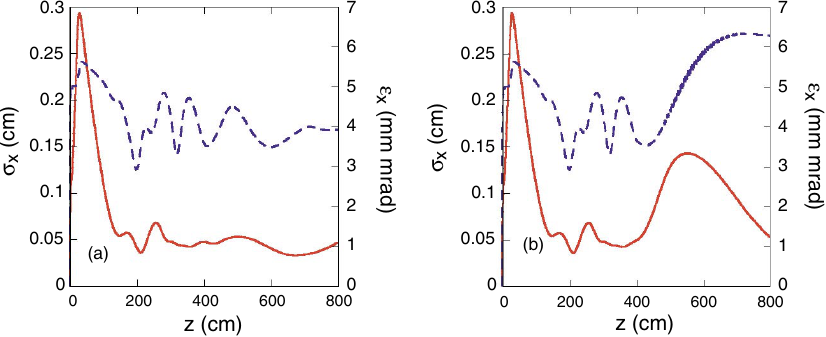
FIG. 22. (Color) PARMELA simulation of the rms spot size (solid line) and normalized emittance (dashed line). In (a) the solenoid strengths are chosen to keep the beam size constant in the compressing and accelerating sections. The beam is mismatched in (b), resulting in emittance growth.